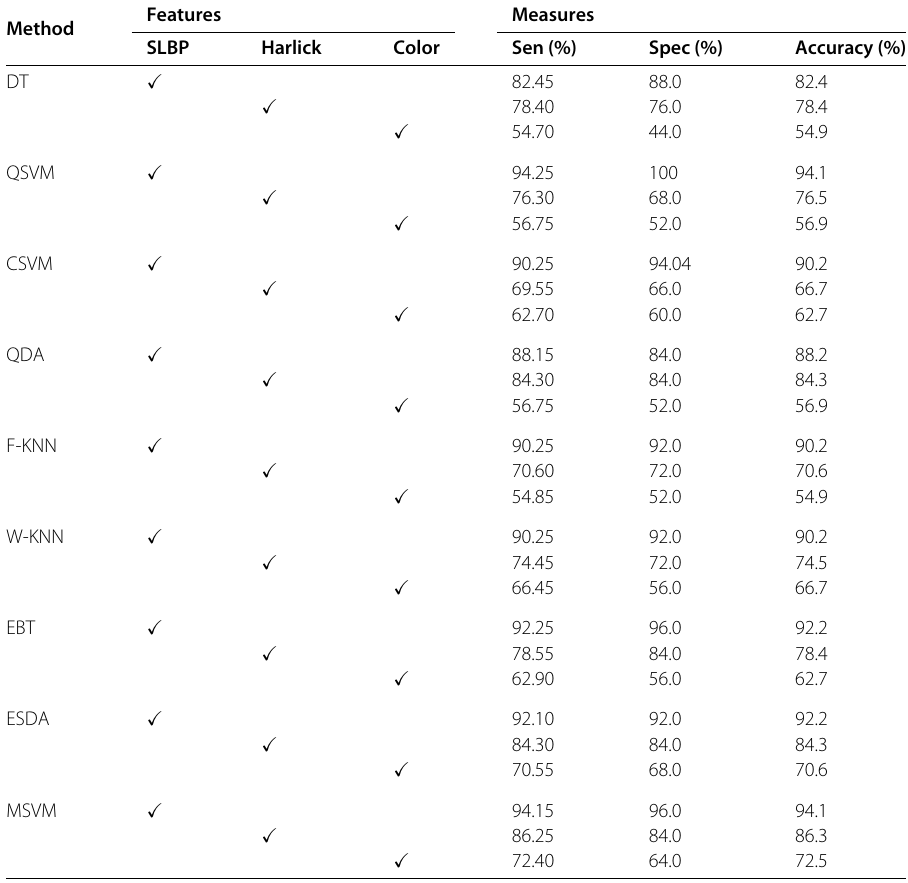
Table 4 Classification result on each extracted set of features for apple scab disease